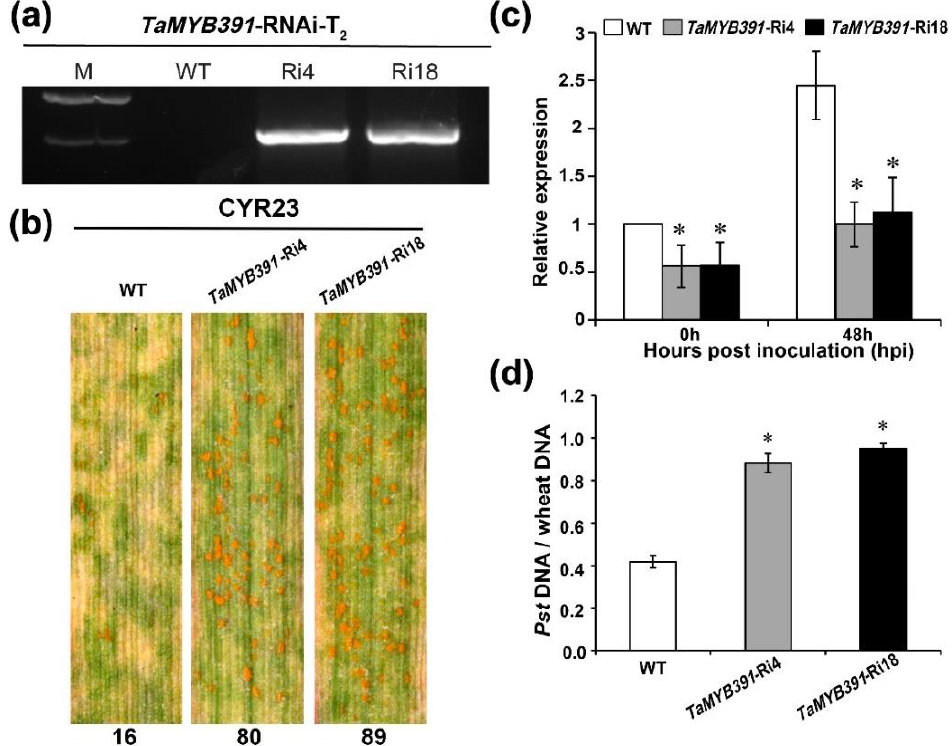
Figure 4. RNAi-mediated silencing of TaMYB391 enhances wheat susceptibility to Puccinia striiformis f.sp. tritici infection. ( a ) RNAi lines in the T 2 generation, TaMYB391 -Ri4 and TaMYB391 -Ri18